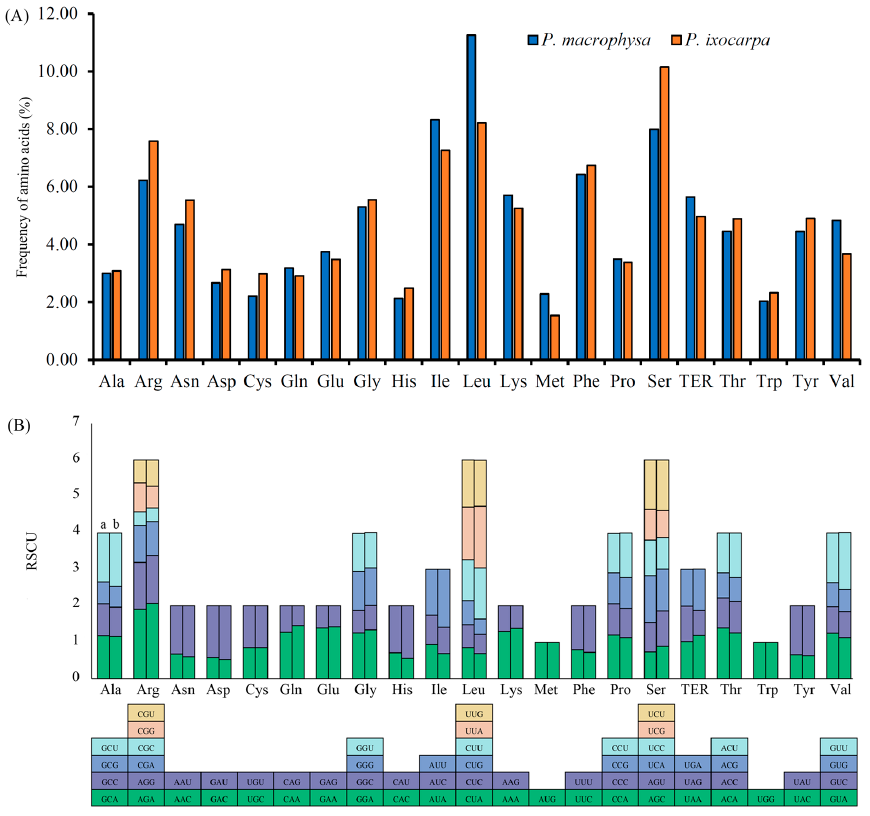
Figure 2. The frequency of amino acids ( A ) and the number of RSCU of amino acids ( B ) in the cp genomes of PMA and PIX. (a) PMA, (b)